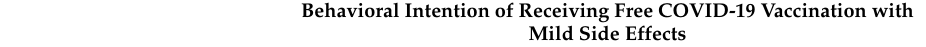
Table 2. Background factors of behavioral intention of COVID-19